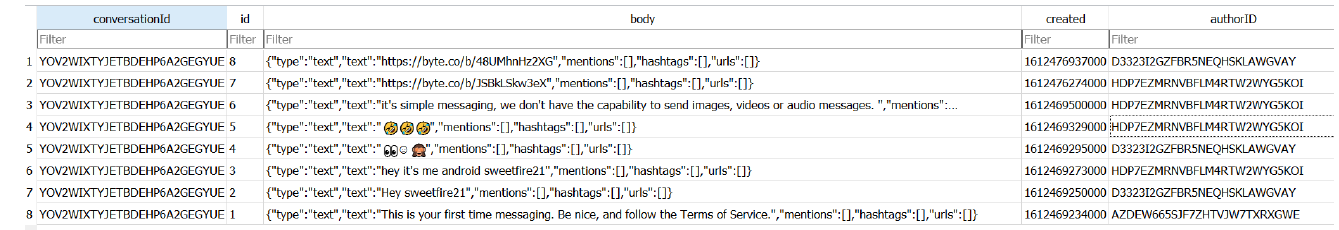
Figure 3. Conversation between Byte Android accounts from byte.db\DbChatMessage as shown in DB Browser for SQLite.